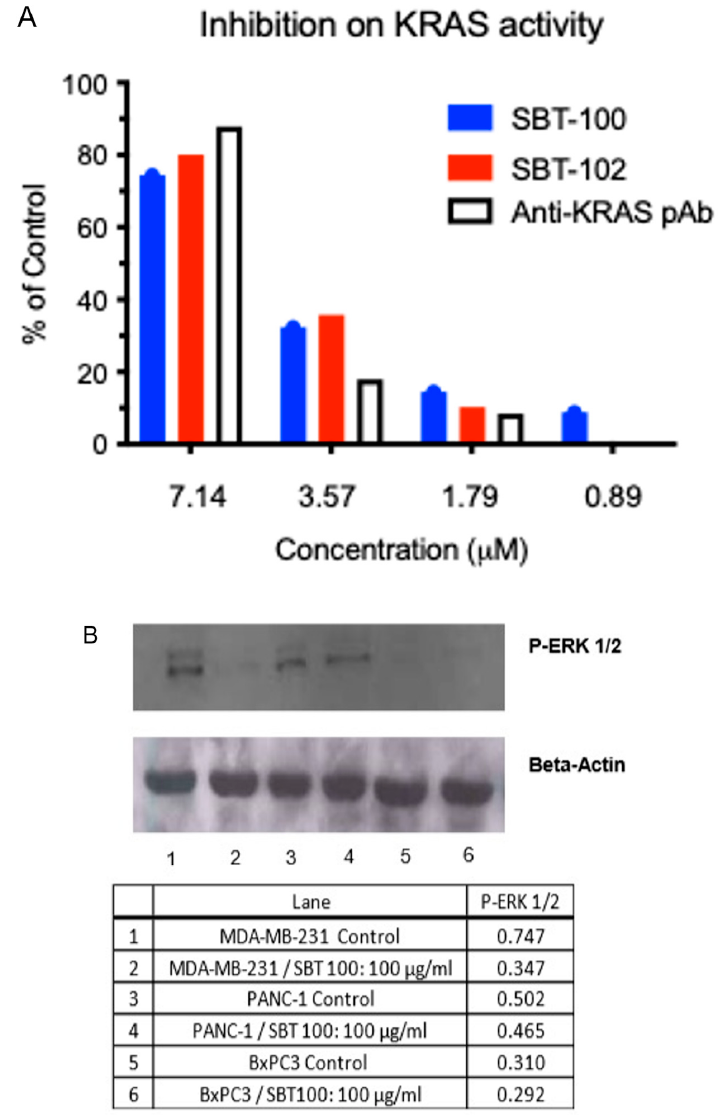
Figure 6. SBT-100 inhibits the GTPase activity of KRAS and stifles downstream ERK phosphorylation in KRAS mutant cancer cells. ( A ) Luminescence (RLU) was measured as a readout for KRAS GTPase activity. Reagents were incubated with either SBT-100, SBT-102, or anti-KRAS polyclonal antibody, and RLU were measured. ( B ) Western blot analysis for phosphorylated ERK1/2 in various KRAS mutant cancer cells with and without SBT-100 treatment. In Lane 1 (MDA-MB- 231), Lane 3 (PANC-1), and Lane 5 (BxPC3) cancer cells were incubated with a vehicle only. In Lane 2 (MDA-MB-231), Lane 4 (PANC-1), and Lane 6 (BxPC3) cancer cells were incubated with 100 µg/mL of SBT-100 for 72 h. 2.7. Reduction in Tumor Volume In Vivo with SBT-100 in Tumor Bearing Mice Finally, athymic mice were subcutaneously injected with a TNBC cell line (MDA- MB-231) or pancreatic cancer cells (PANC-1) and after approximately 3 weeks of growth, they were treated for 14 days with SBT-100 and allowed to recover for 7 days for observations of tumor volume. MDA-MB-231 tumors were between 50–100 mm 3 prior to initiation of treatment (Figure 7A). These tumor-bearing mice were randomized into a control group which received PBS and a treatment group that received SBT-100. The